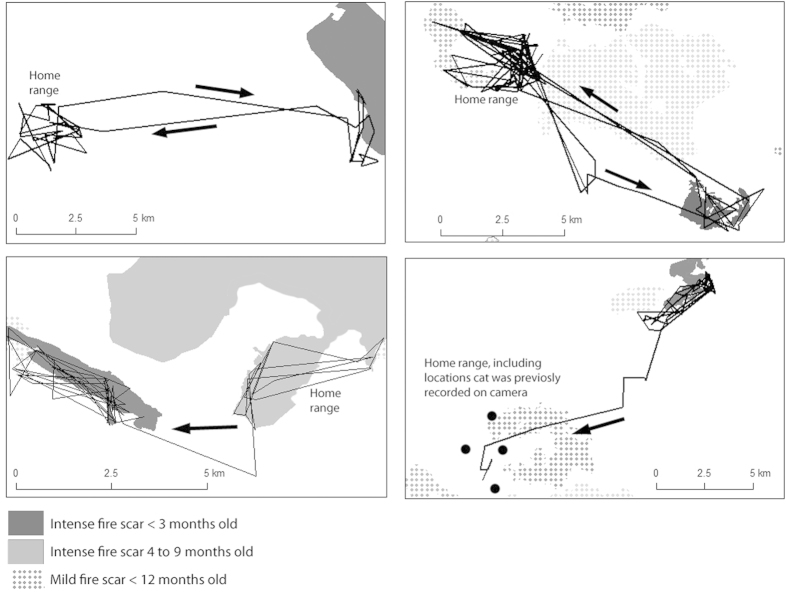
Examples of four of the eight extra-territorial travels to intense fire scars by cats.We created maps in ArcMap 10.1 (www.esri.com), and refined symbology in Photoshop Elements 8.0 (www.adobe.com/au/products/photoshop.html).